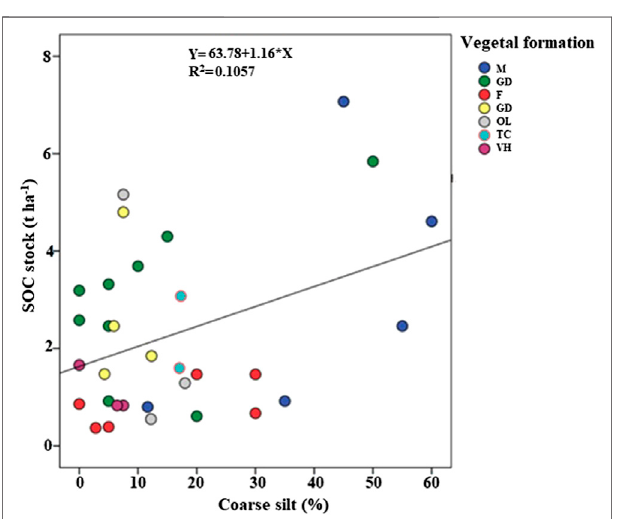
FIGURE 4 | Correlation between coarse silt content and soil organic carbon. M: matorral; GC: sparse garrigue; F: forest; GD: dense garrigue; OL: olive grove; TC: oak coppice; VH: herbaceous